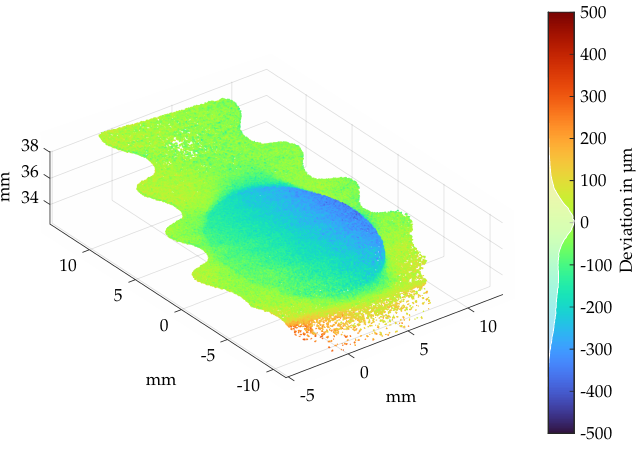
Figure 15. Deviation analysis of the blade root after disassembly forces of 100kN, Figure 14d.